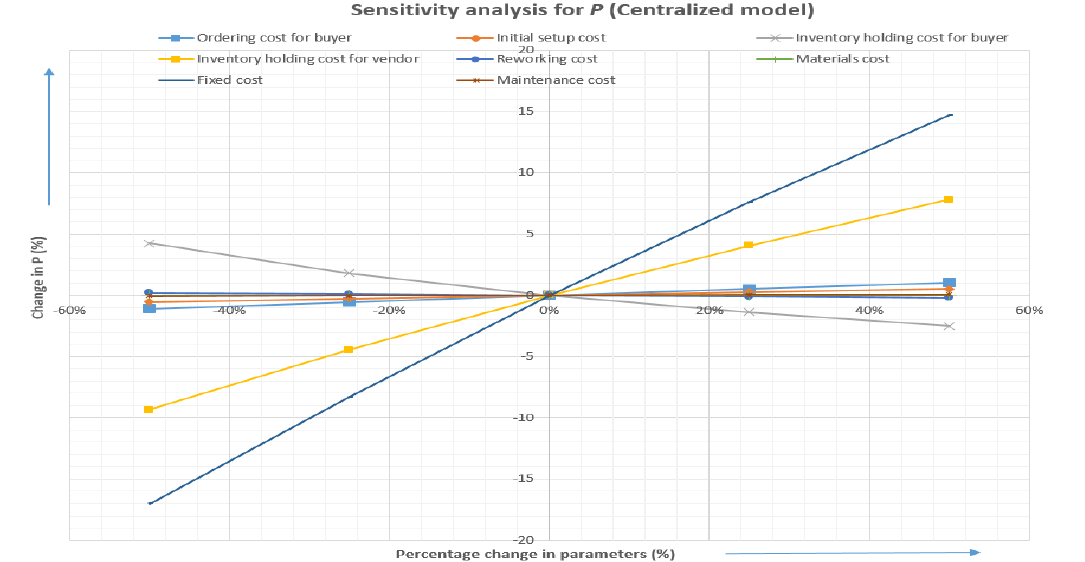
Figure 11. Sensitivity analysis: total cost versus change in parameters under centralized